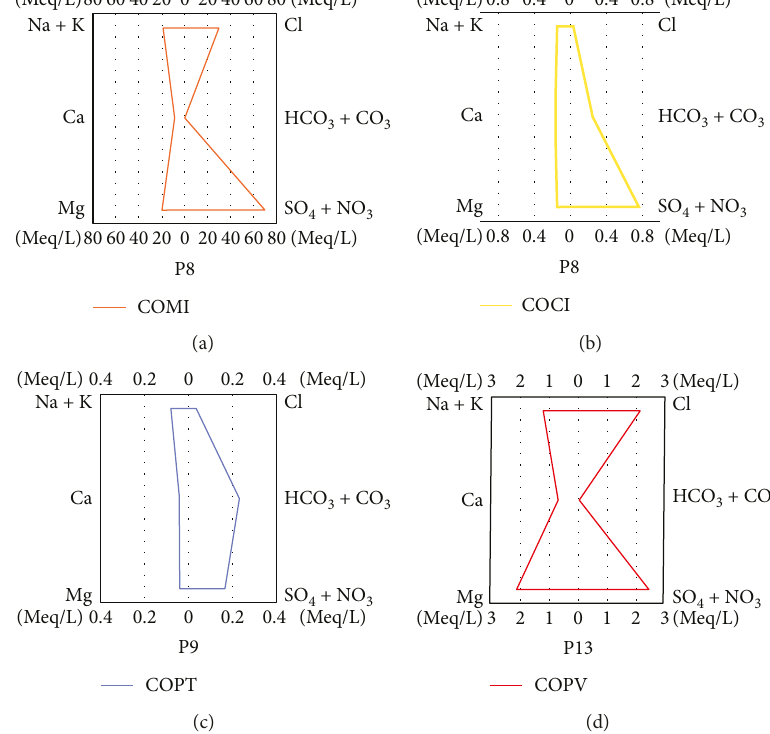
Figure 5: Representative Sti ff diagrams of the sources of the Puracé-La Mina